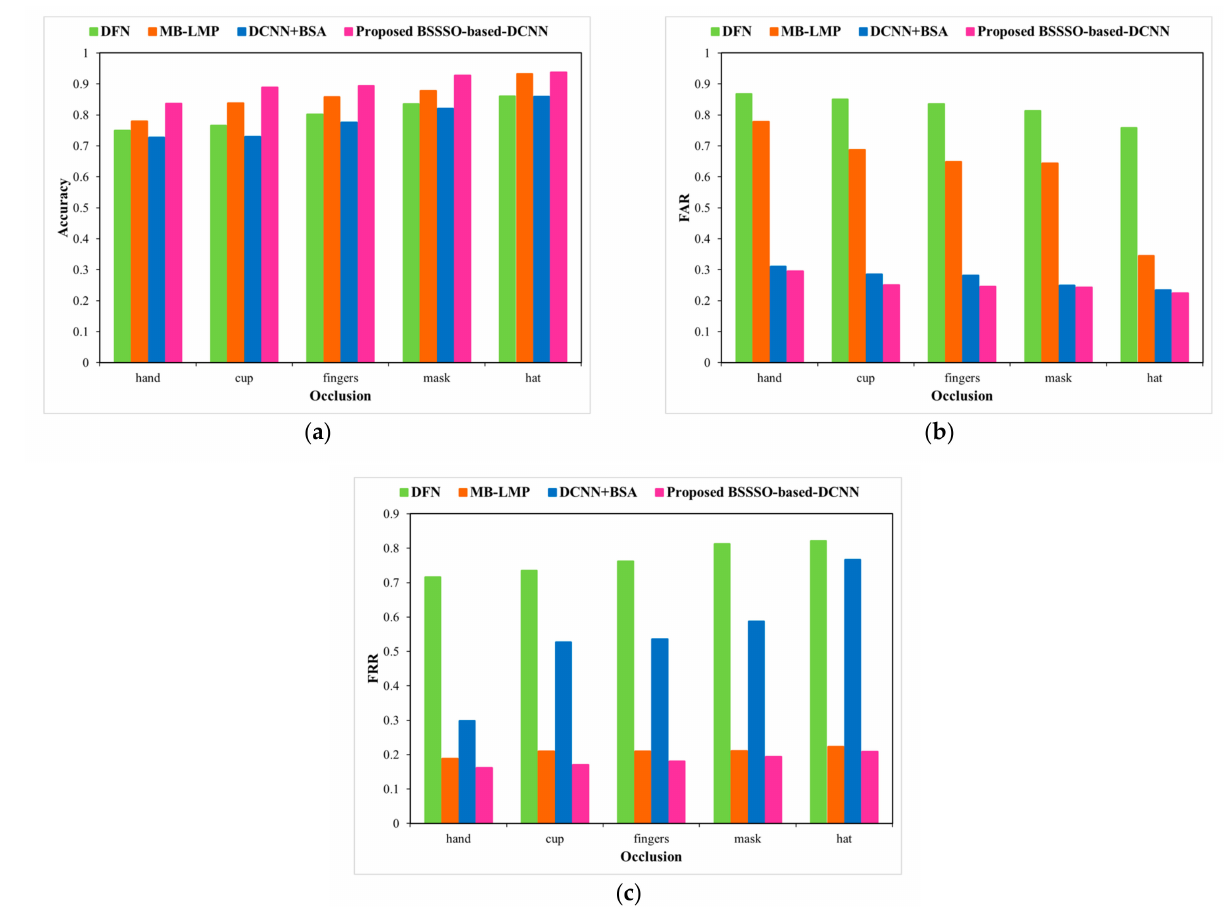
Figure 10. Analysis using UMB-DB database by varying occlusion.